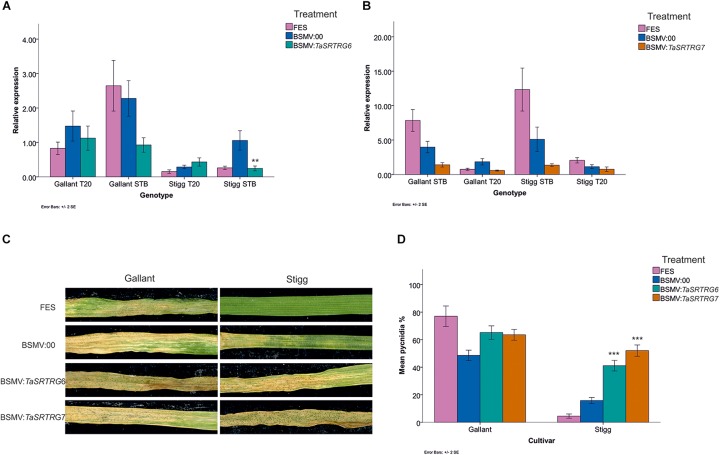
The impact of virus-induced gene silencing of TaSRTRG6 and TaSRTRG7 on the development of Septoria tritici blotch disease in the STB resistant and susceptible cultivars Stigg and Gallant. Viral RNA was applied to the second emergent seedling leaves and gene expression was quantified in the third leaves, while disease was assessed in the fourth leaves. This experiment included three trials, each with four independent replicates per treatment (12 biological replicates per treatment). (A,B) Analysis of the efficacy of VIGS of TaSRTRG6 and TaSRTRG7, respectively, 12 days post inoculation with Z. tritici isolate Cork Cordiale 4 (19 days post inoculation with BSMV). Relative expression was calculated using the 2(–ΔΔCt) formula, using the average of the two reference genes GAPDH and Alpha tubulin. FES is the VIGS application buffer; BSMV:00 is the empty vector control and BSMV:TaSRTRG6 and BSMV:TaSRTRG7 denote the silencing treatments for TaSRTRG6 and TaSRTRG7, respectively. Significance denoted by a double asterisk denotes a P-value of ≤ 0.01 as compared to its respective BSMV:00 control treatment of the same genotype. Bars indicate SEM. (C) Visualization of the effect of VIGS on STB disease development at 21 days post inoculation with Z. tritici. (D) Quantification of the effect of VIGS on STB disease development (diseased leaf area bearing pycnidia) on wheat cultivars Gallant (left) and Stigg (right) at 21 dpi. Asterisks (***) signify P ≤ 0.001 as compared to the BSMV:00 control (blue bar) within a given genotype cluster. Bars indicate SEM.